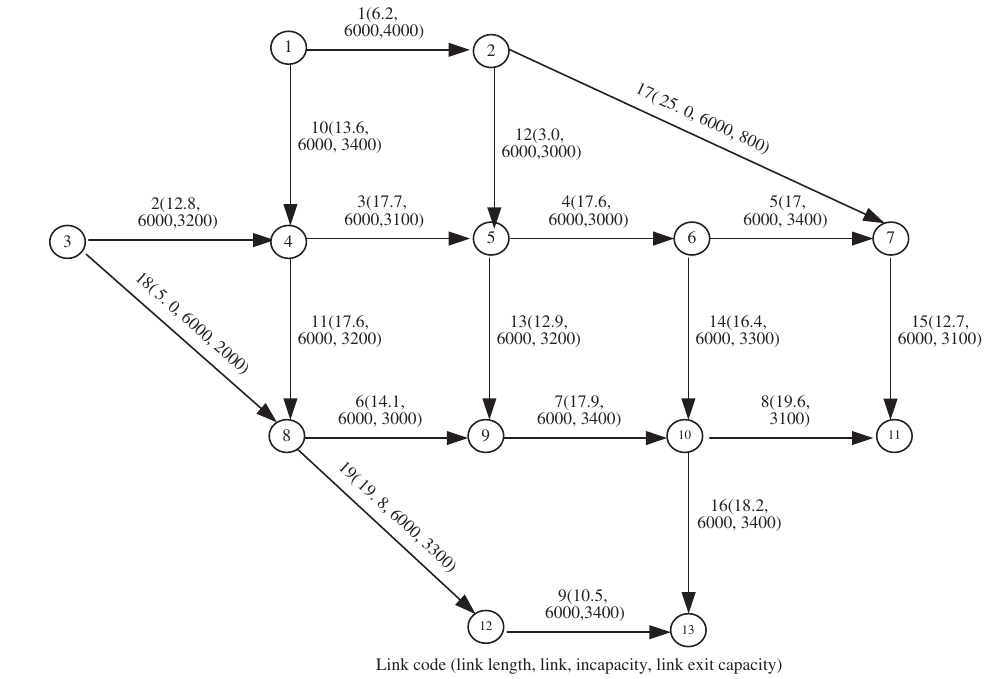
Fig. 2. Simulation